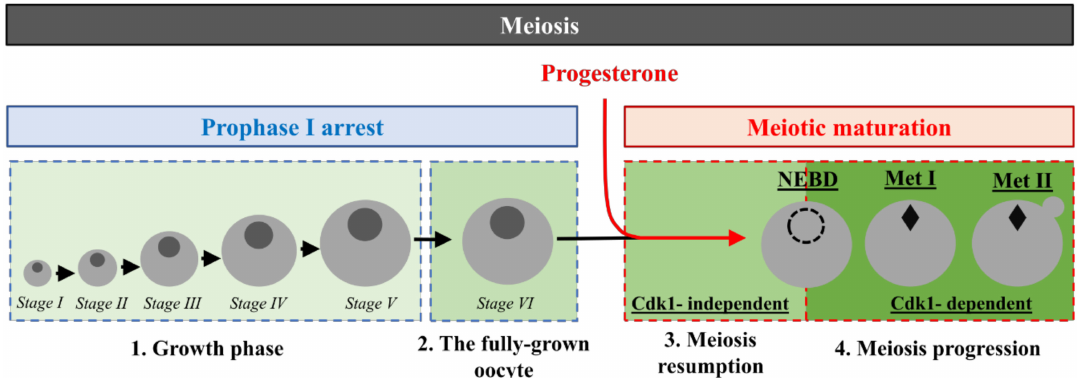
Figure 1. Four phases of Xenopus oocyte meiosis. ( 1 ) The growth period: Oocytes enter prophase of the first meiotic division and arrest at the diplotene stage (Prophase I). Growing oocytes have been classified into six stages by Dumont [31]. ( 2 ) The fully-grown oocyte: when oocyte growth is complete, transcription and vitellogenesis stop, and oocytes become competent to undergo meiotic maturation. ( 3 ) Meiosis resumption: Progesterone releases the prophase arrest and oocytes resume meiosis. ( 4 ) Meiosis progression: Following nuclear envelope breakdown (NEBD), oocytes